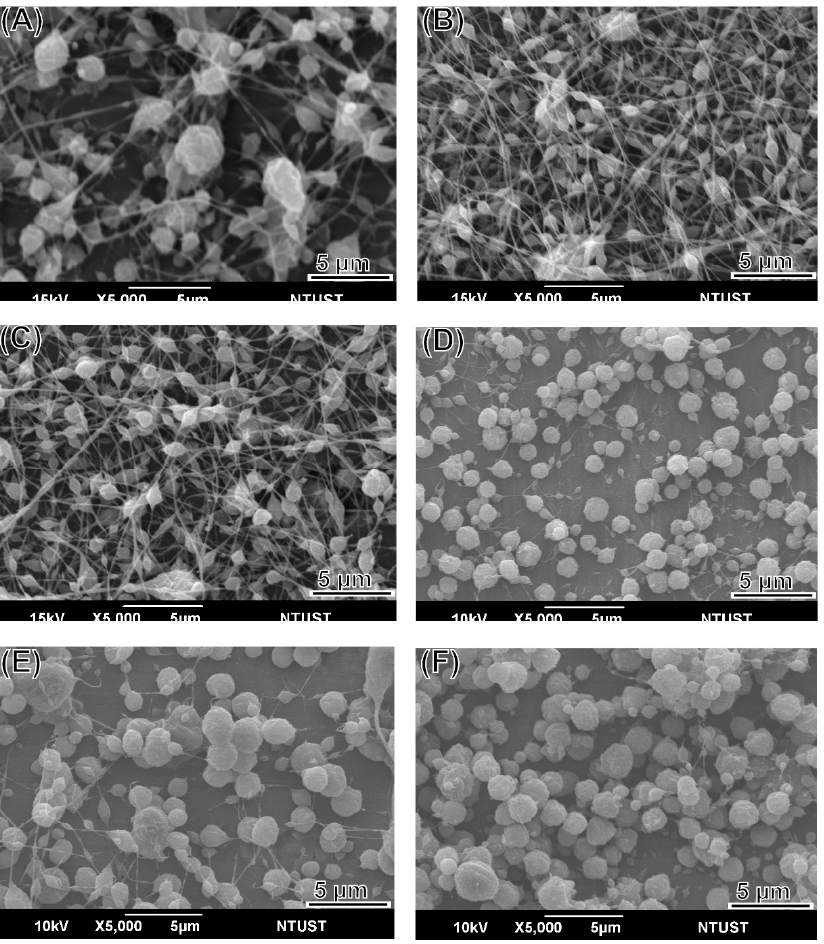
Figure 3. SEM images of levamisole (LEVA)/PVP/PMMA microparticles produced from a series of different concentrations of LEVA: ( a ) 1250 µg/mL, ( b ) 625 µg/mL, ( c ) 312.5 µg/mL, ( d ) 156.25 µg/mL, ( e ) 78.125 µg/mL, ( f ) 39.0625 µg/mL.